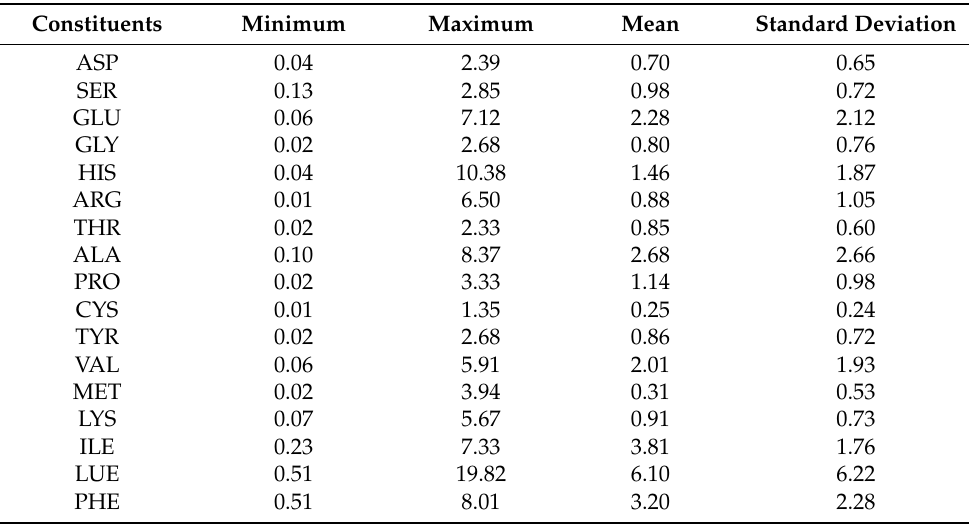
Table 1. Descriptive statistics summary of amino acids in QPM (N = 63).